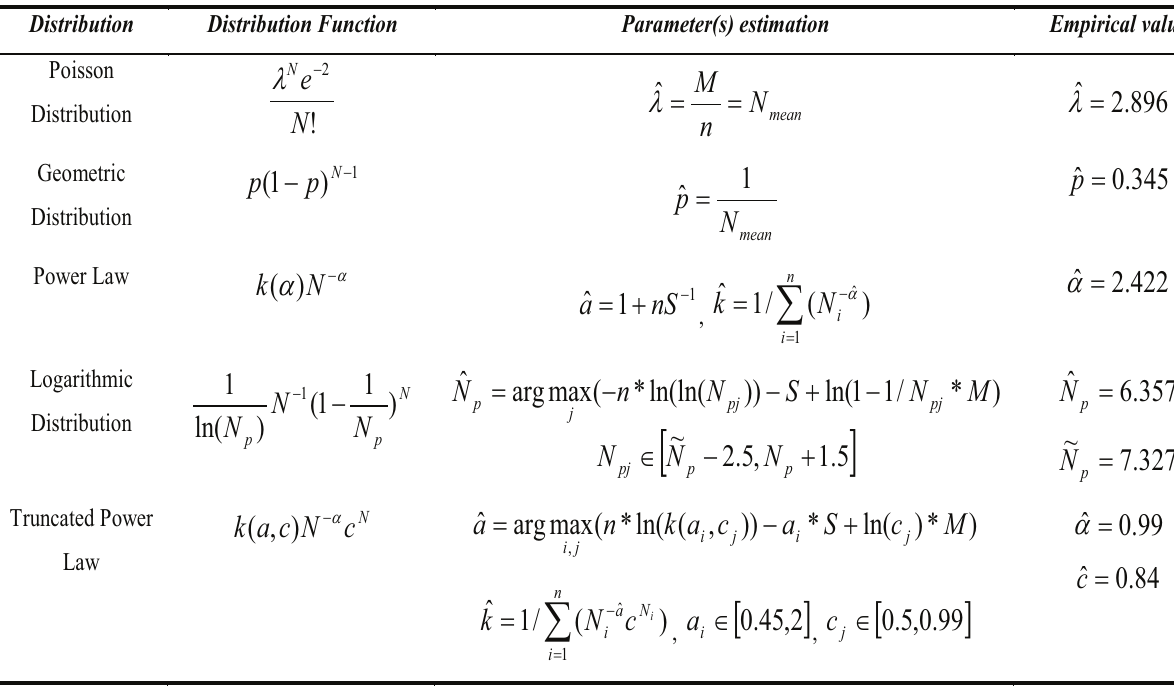
Figure 2. Maximum likelihood estimation for optional models. Where n =6070 is the sample size, i.e. total number of groups observed; N i (i=1,…,n) are all the observations, i.e. number of individuals in group i; and for convenience, we denote M ~ P logarithmic distribution, the normalization factor is 1 (cid:4) ln N p (cid:5) (cid:6) (detailed derivation can be found in 23]). ~ NN p is the expected group size experienced by a randomly chosen individual, calculated directly from the data according to equation 4. We first calculated ~ NN p and then searched the neighborhood of ~ NN p to get the ^ NN p which maximizes the likelihood function.